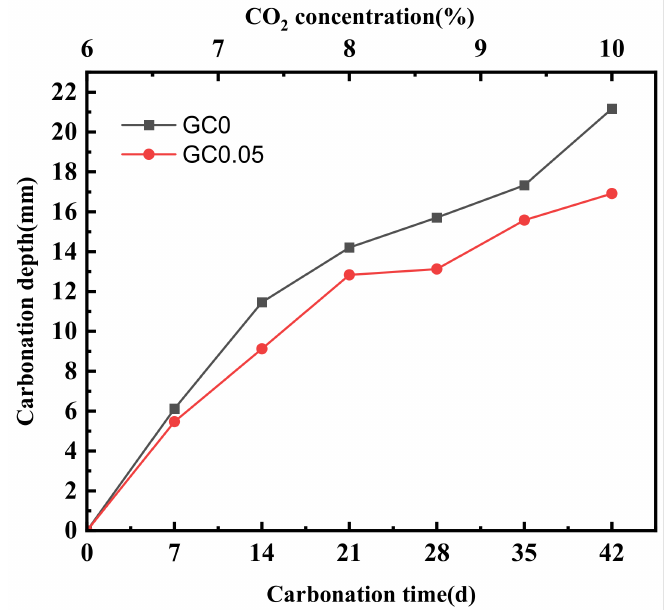
Figure 4. Relationship between concrete carbonation depth, time, and CO 2